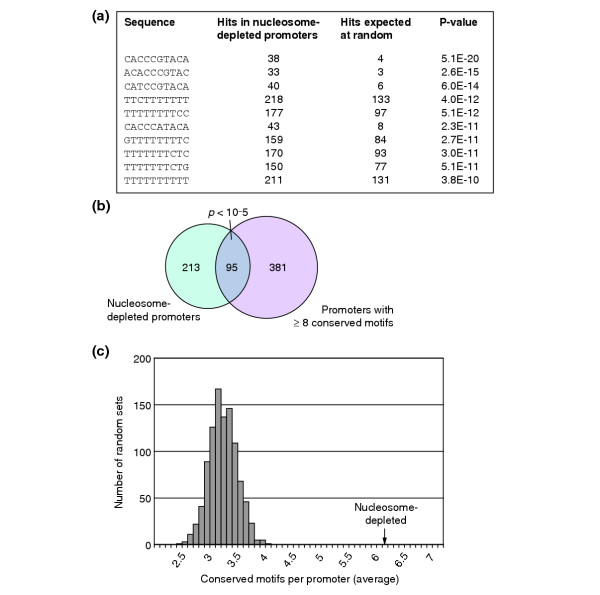
Sequence motifs over-represented in nucleosome-depleted promoters. (a) An unbiased search for sequences up to 10 bp in length over-represented in nucleosome-depleted promoters (relative to promoters overall) identified the poly(dA.dT) sequence element and variants of the Rap1 consensus motif ACACCCATACAT [21]. (b) Overlap between nucleosome-depleted promoters and promoters that contain multiple conserved motifs is shown [21]. (c) Histogram showing average numbers of motifs in 1,000 randomly generated promoter sets. Nucleosome-depleted promoters contain an average of 6.1 conserved motifs, significantly higher than in these randomly generated sets.